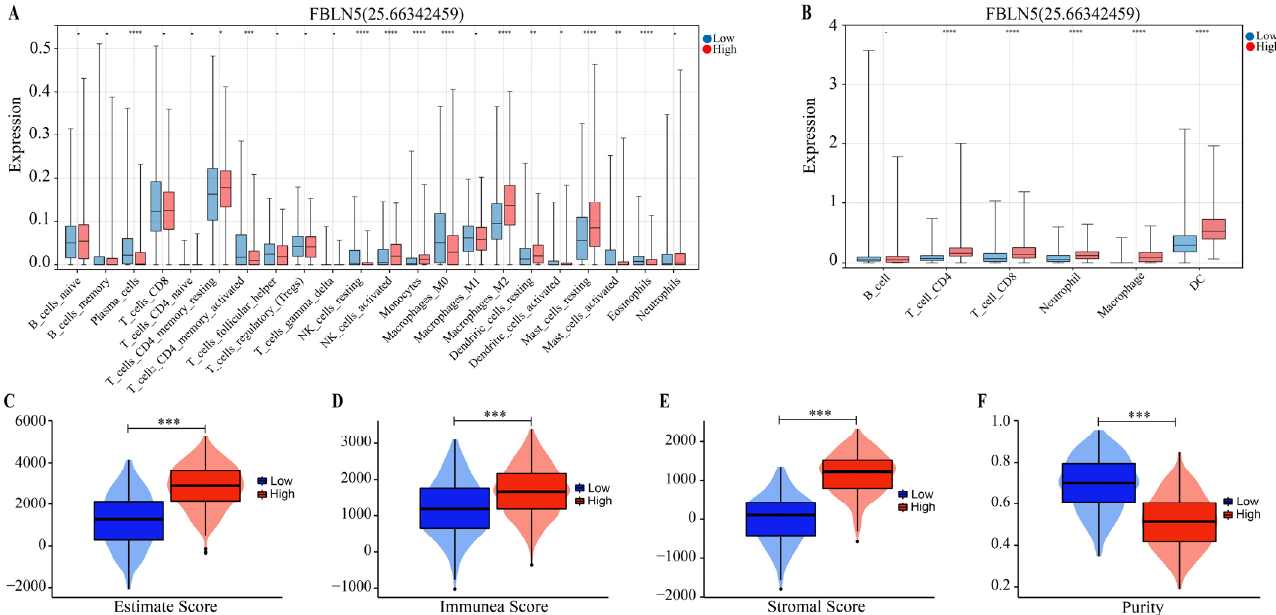
Figure 4. Relationships between FBLN5 and immunity. ( A ) CIBERSORT and ( B ) TIMER algorithms preliminarily predicted the relationship between the FBLN5 expression levels and immune infiltration in each tumor sample. The ( C ) ESTIMATE algorithm estimated the content of immune and stromal cells in GC, and helped to predict the ( D ) immune score, ( E ) stromal score, and ( F ) tumor purity. * p < 0.05, ** p < 0.01, *** p < 0.001, **** p < 0.0001 .